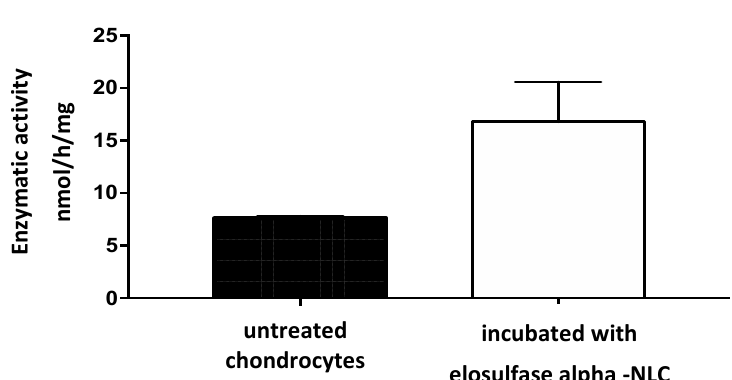
Figure 10. N-acetylgalactosamine 6-sulphatase (GALNS) enzyme activity in untreated chondrocytes